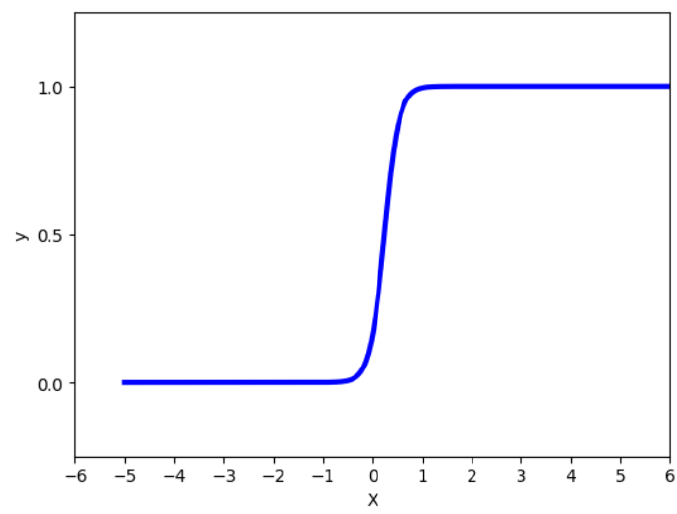
Figure 5. Logistic function or sigmoid curve [21].